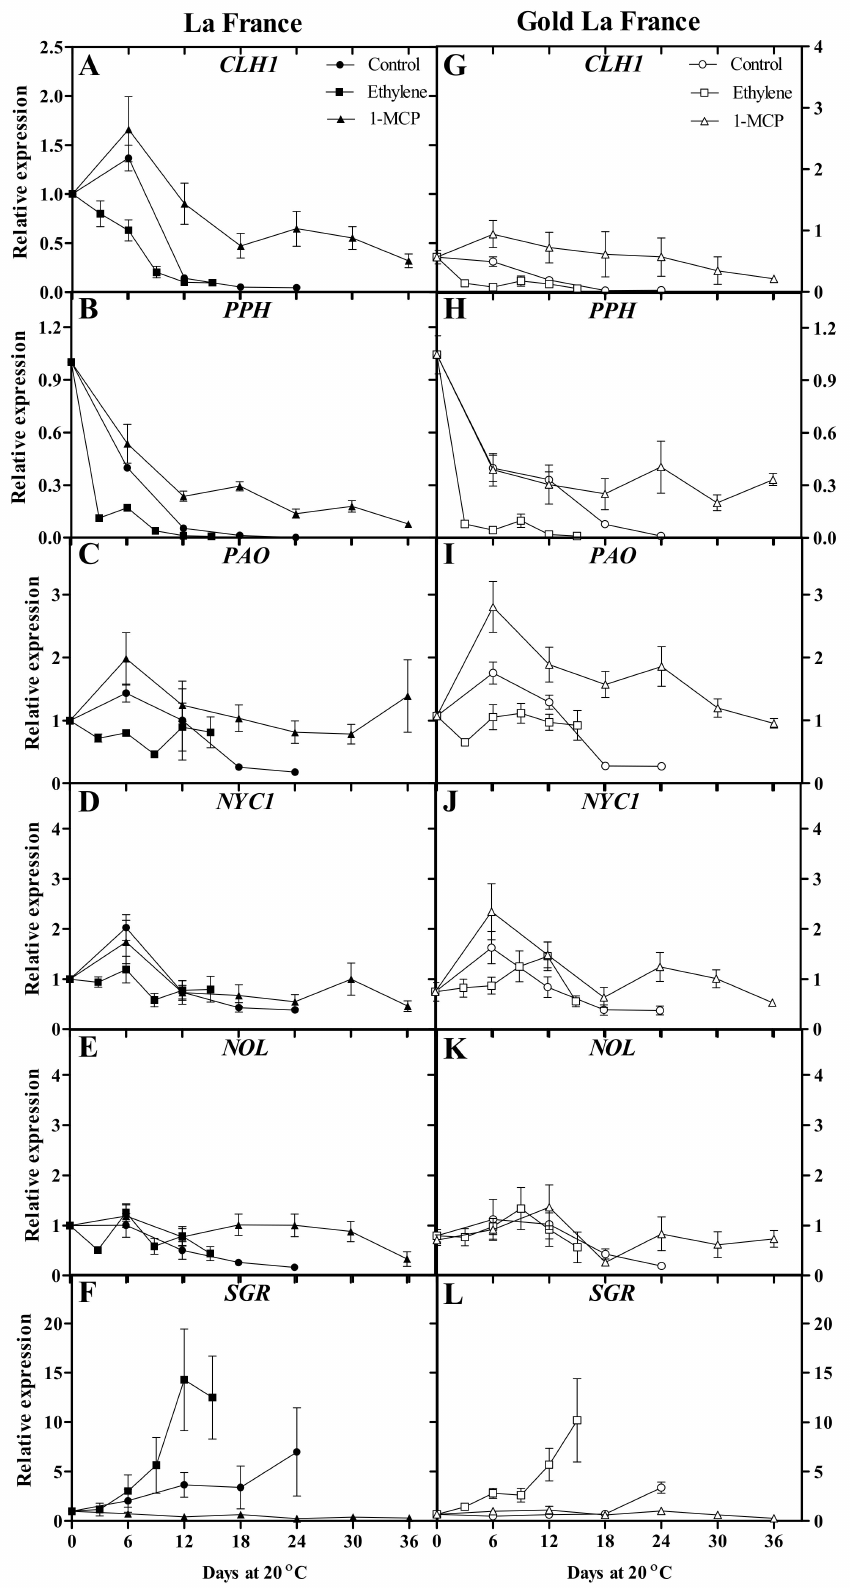
Figure 7. Relative expression of CLH1 ( A , G ), PPH ( B , H ), PAO ( C , I ), NYC1 ( D , J ), NOL ( E , K ) and SGR1 ( F , L ) in ‘LaFrance’ and ‘Gold La France’ fruit treated with ethylene and 1-MCP during ripening at 20 ◦